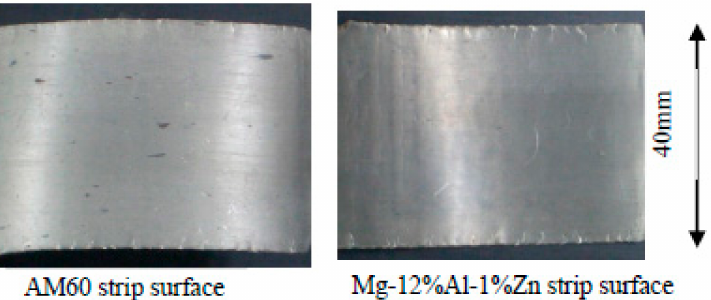
Figure 25. Surfaces of hot-rolled clad strip consisting of an AM60 strip and a Mg-12%Al-1%Zn